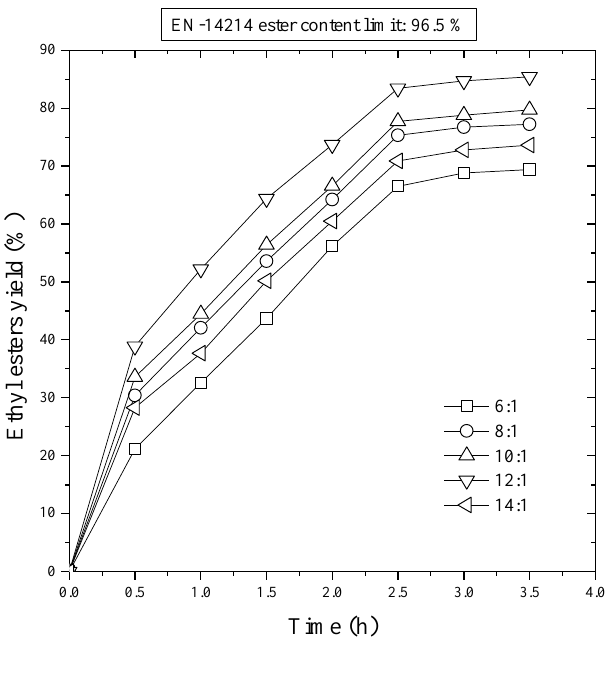
Figure 3. First stage transesterification. Effect of the molar ratio of ethanol to sunflower oil on ethyl ester yield. NaOH/oil mass ratio, 1.0%; reaction temperature, 80